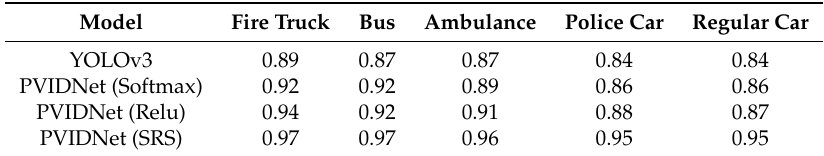
Table 16. Accuracy results of the DL algorithms classifying the images of Fire Trucks, Buses, Ambulances, Police Cars, and Regular Cars in the testing phase considering together the right, left, and front